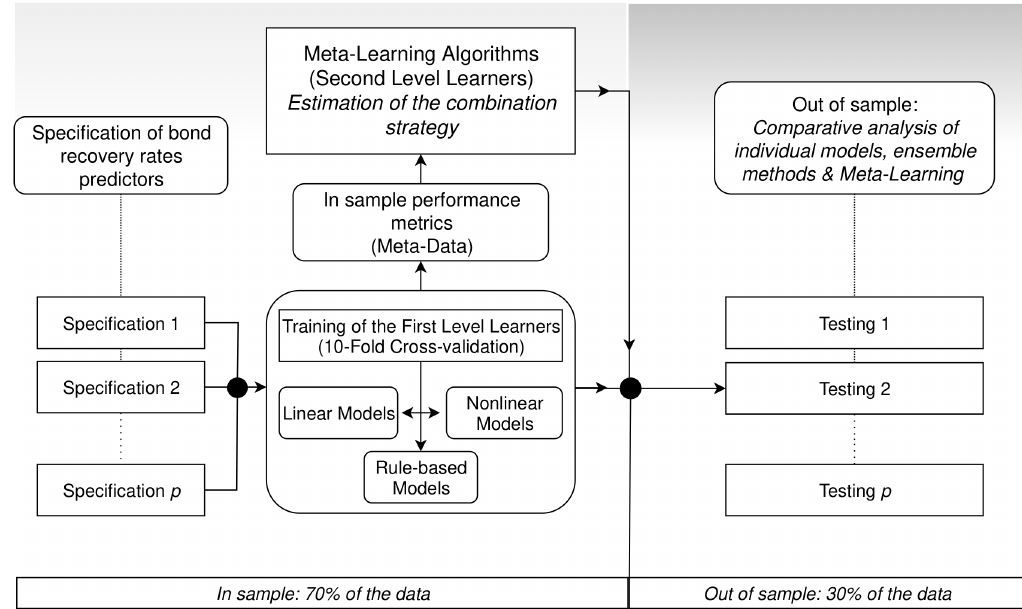
Figure 1. Predictive strategy with meta-learning